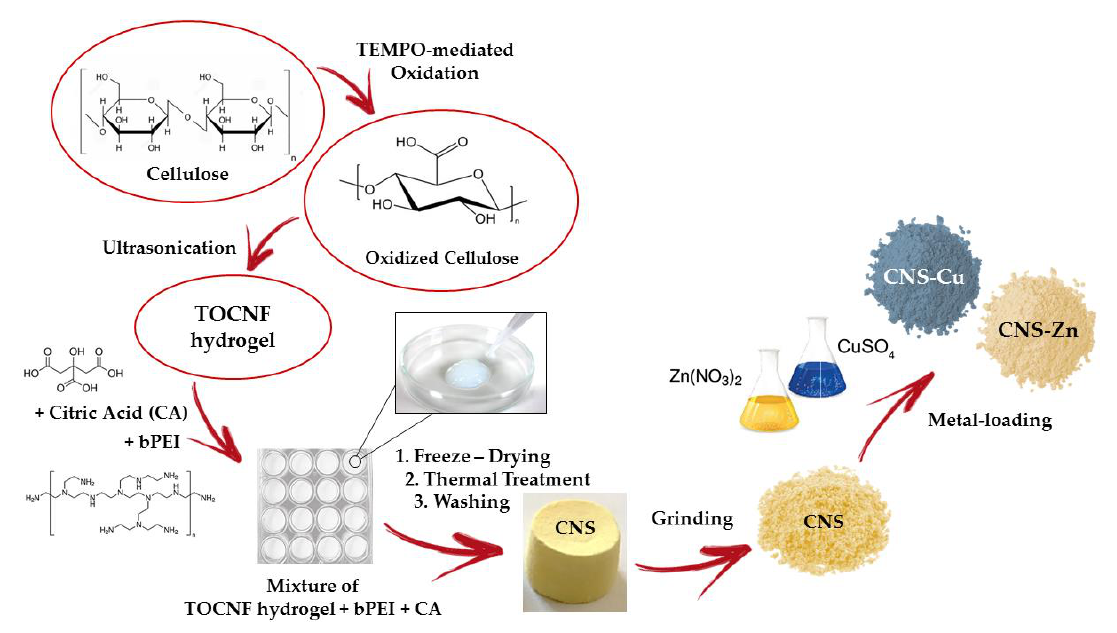
Table 1. ICP-OES analysis result for the sample before the reactions. I, II and III indicate three dif- ferent samples on which measurements were